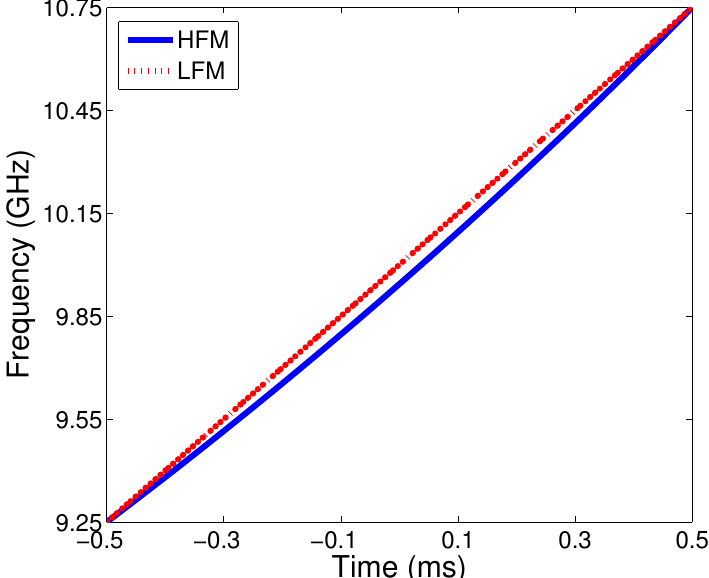
Figure 2. The instantaneous frequency of HFM and LFM waveforms, B = 1 . 5 GHz, f = 10 GHz, T = 1 . 0 c p